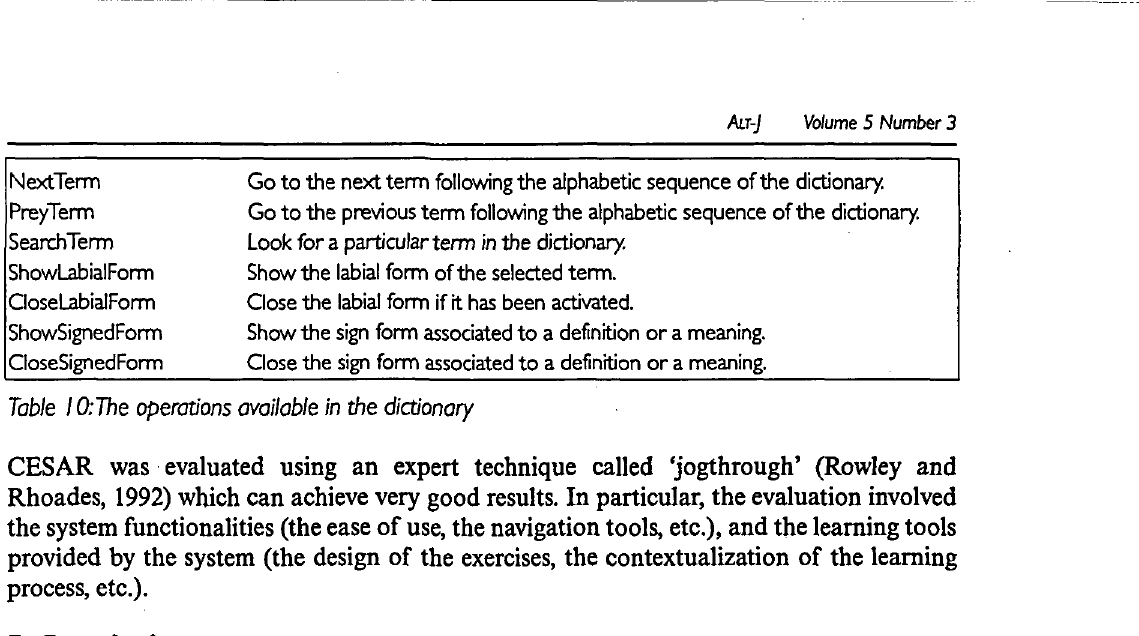
Table 10:The operations available in the